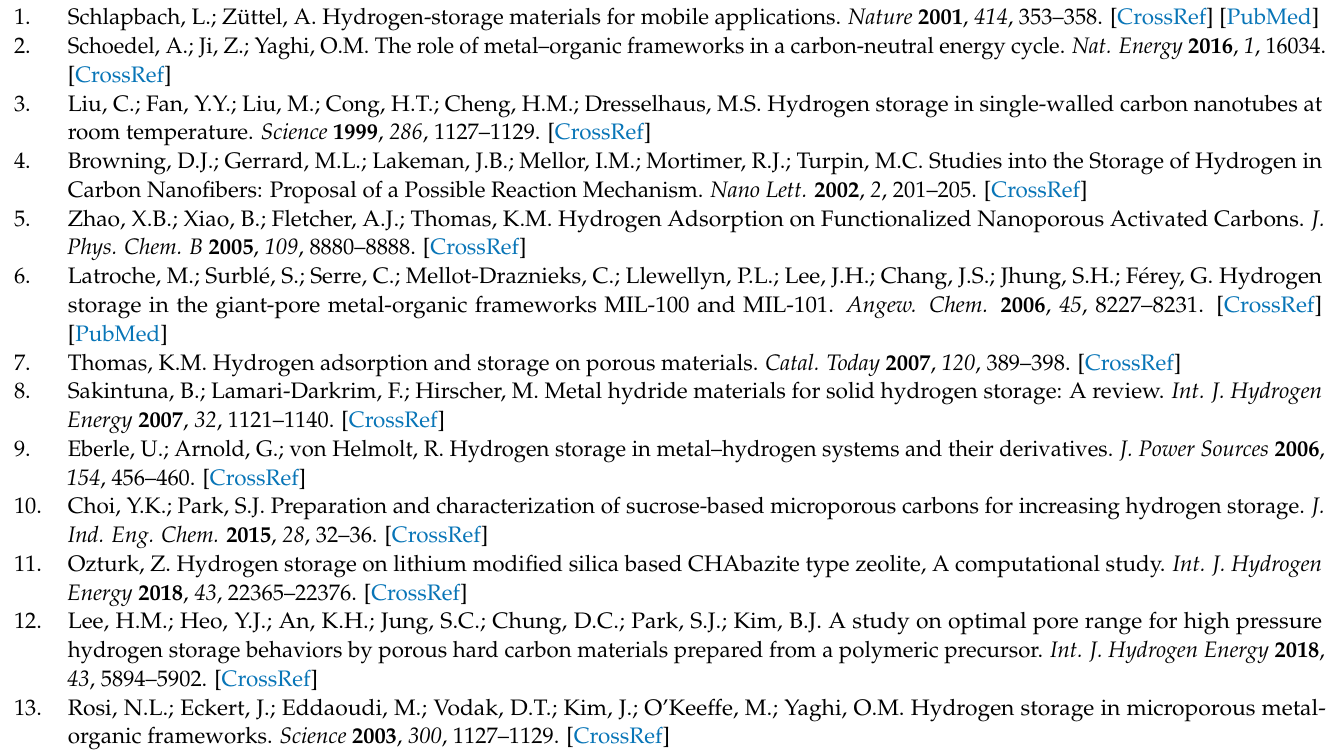
Figure S2: The XPS survey scans of CGB- d -hydrochar and CGB-AC samples. Figure S3: Total H 2 uptakes of CGB-AC samples at 77 K and 20